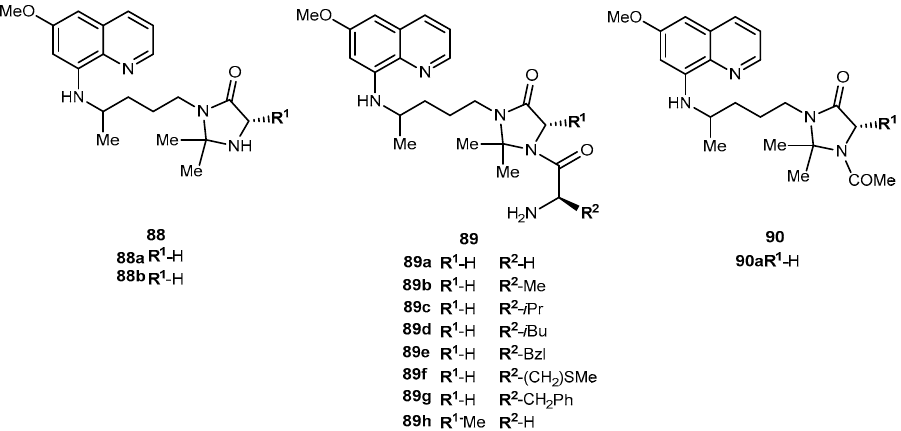
Figure 38. Structures synthesized of imidazolidin-4-one derivative of 4 and tested against P. berghei